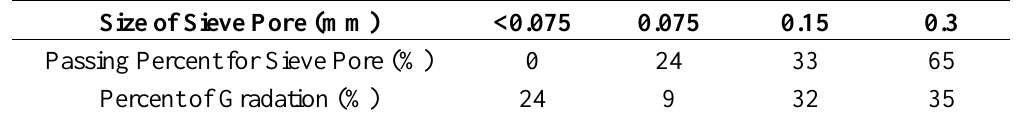
Table 1. Gradation of the fine aggregate asphalt